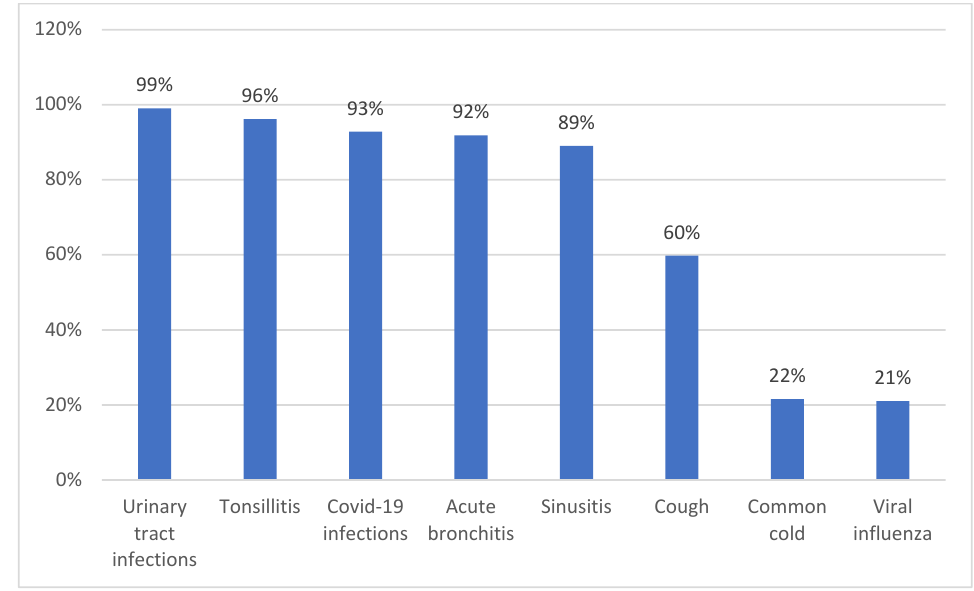
Figure 2. Proportion of respondents prescribing antibiotics empirically for common conditions for symptom relief and prevention of complications.